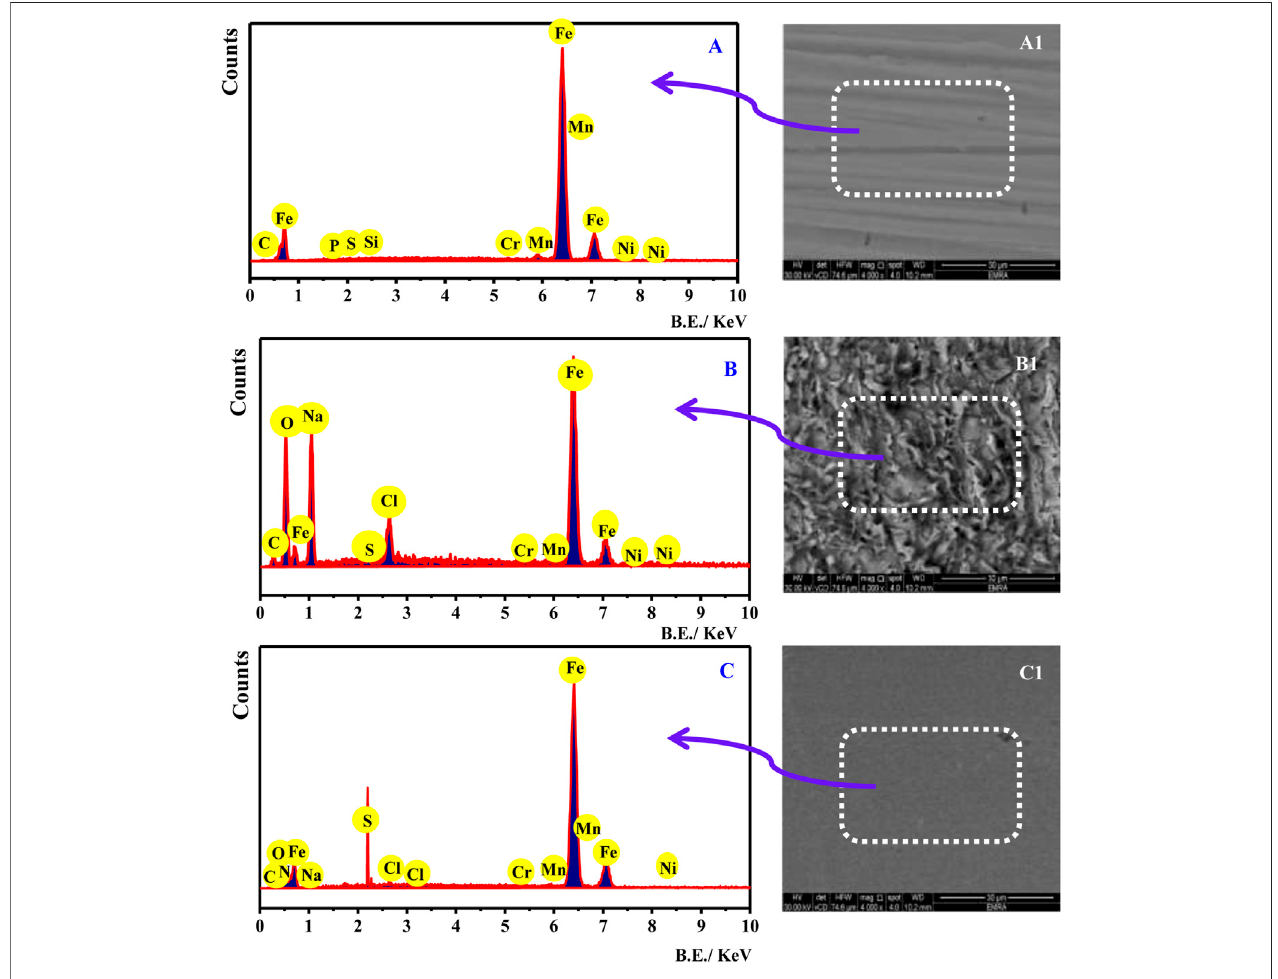
FIGURE 8 | EDX analysis (A – C) and FESEM (A1 – C1) micrograph of (A) pristine C-steel, (B) C-steel immersed in blank 3.5% NaCl saturated with CO 2 , and (C) C-steel immersed in 3.5% NaCl saturated with CO 2 containing 150 ppm CSD for 20 h.